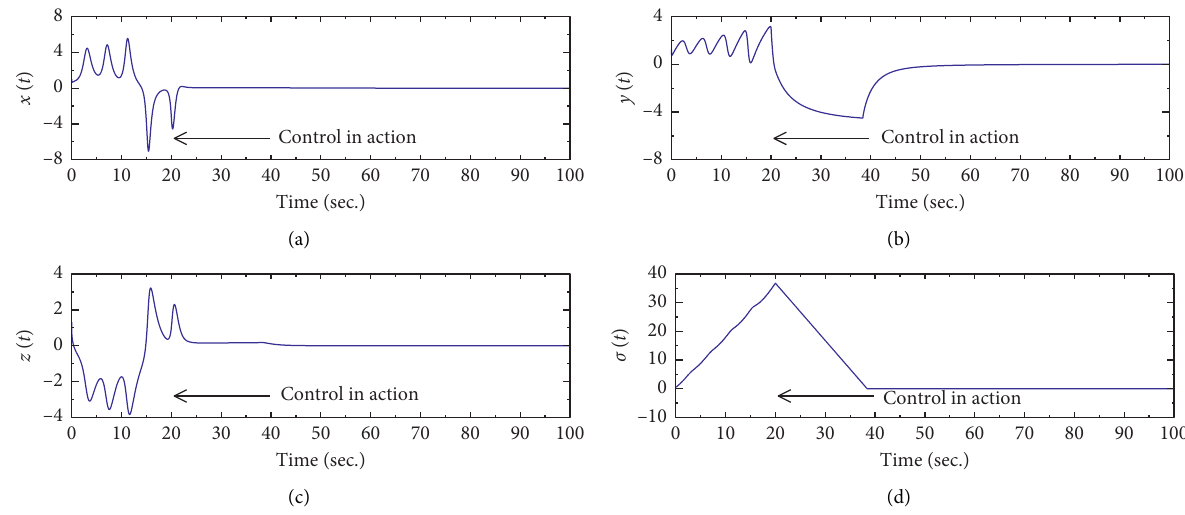
Figure 11: The time series of the controlled commensurate fractional-order system state variables and corresponding time series of the sliding surface without uncertainty and external disturbance (the control input is activated at t � 20